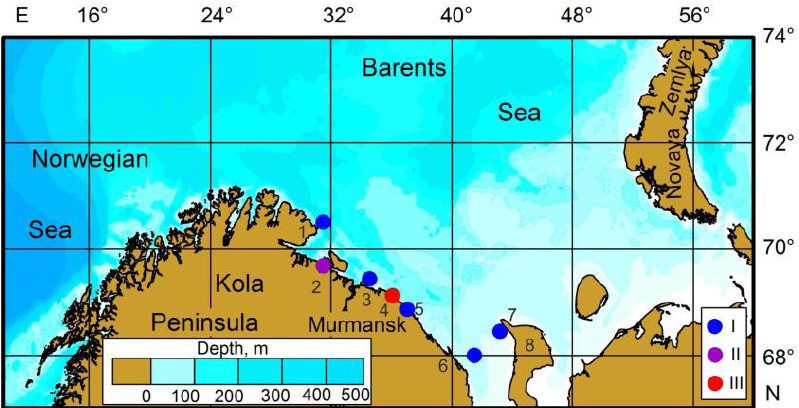
Figure 1. Locations in the coastal Barents Sea where Coryne hincksi hydrozoans were recorded. I — findings by Scheuring [42] in 1913, II — finding by Panteleeva [43] in 2002, III — present findings in Zelentskaya Bay during 2009 – 2022. 1 — Vardø, 2 — Ambarnaya Bay, 3 — Kildin Island, 4 – Ze- lenetskaya Bay, 5 — Sem Ostrovov Area, 6 — Cape Svyatoy Nos, 7 — Cape Kanin Nos, 8 — Kanin Peninsula.